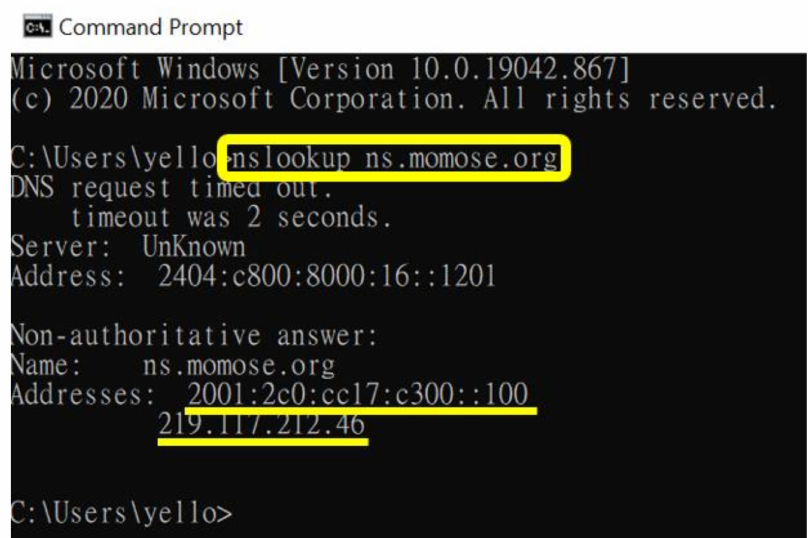
Figure 2. Example of executing nslookup on Command Prompt.